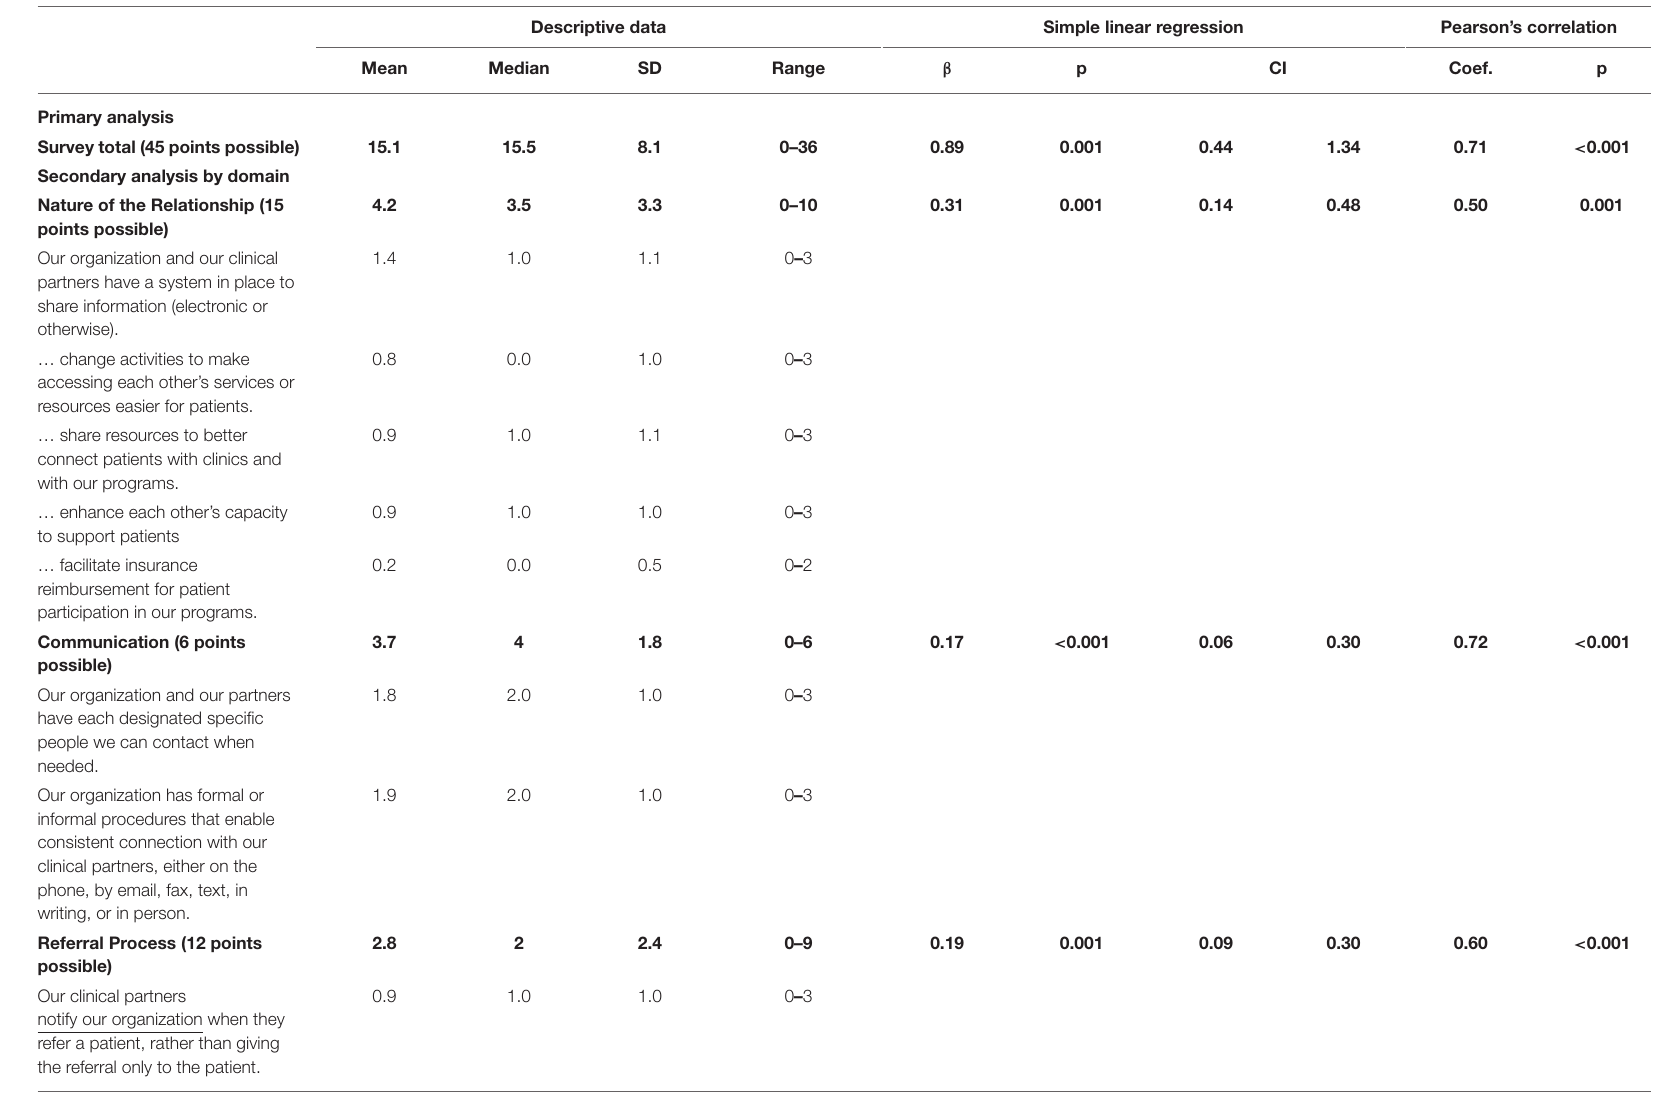
TABLE 3 | Descriptive data and results of criterion validity testing of the clinical-community linkage self-assessment, 2017 ( n = 38) a